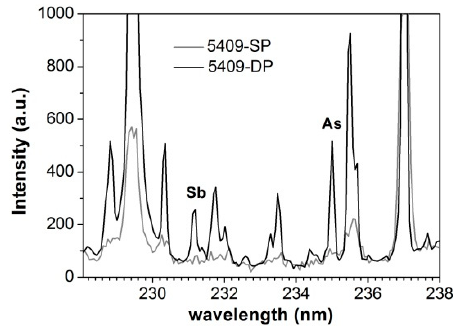
Figure 6. Comparison of two averaged (20 measurements) spectra acquired in close proximity on the Egyptian bronze figurine with the proposed DPP- and the SP-LIPS system of Agresti et al. [18].